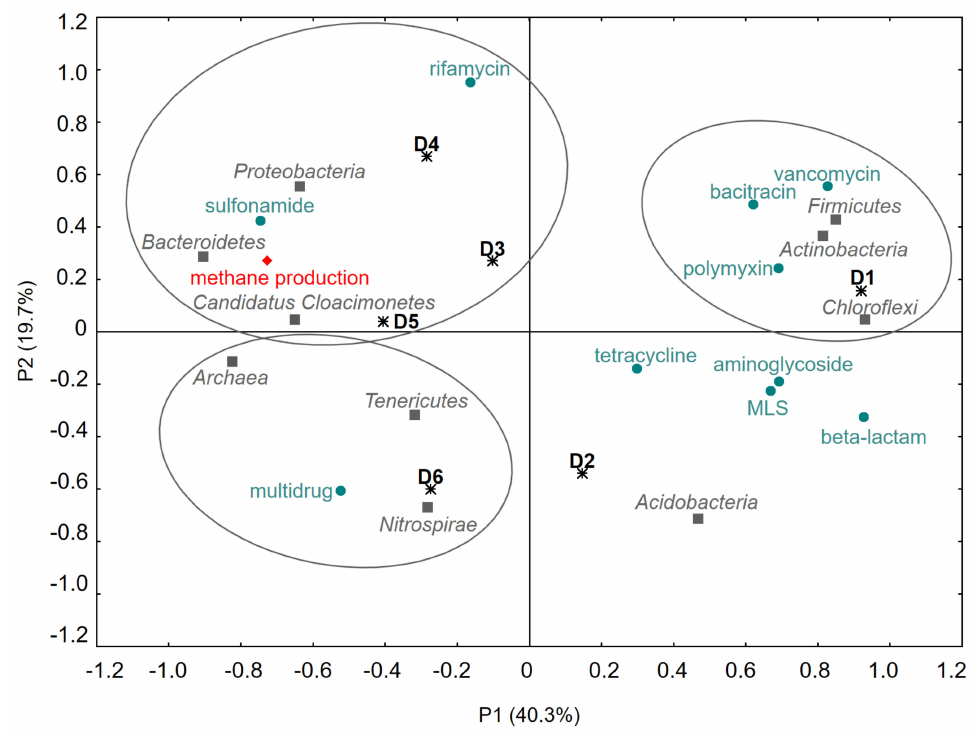
Figure 9. Ordination analysis of samples from the process bioreactors (D1–D6). Principal component analysis (PCA) of microbial abundance, ARG abundance and methane production. D-dose